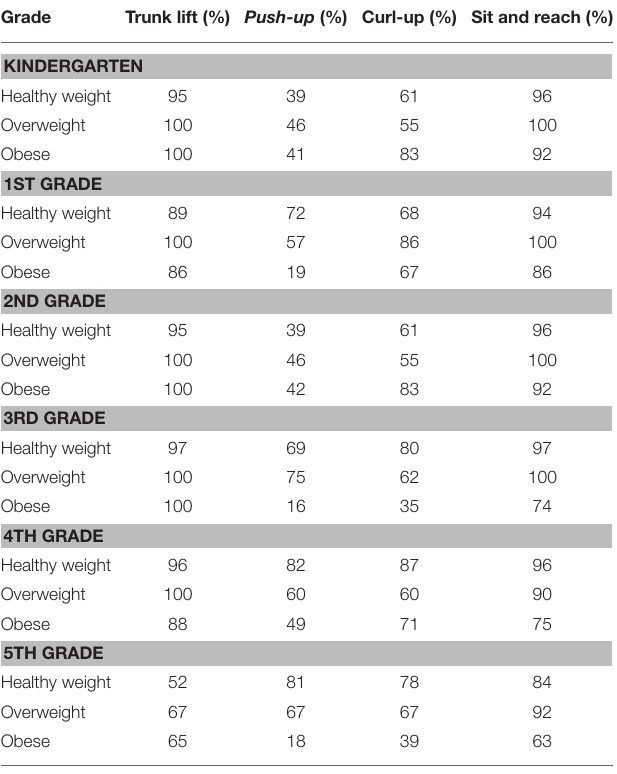
TABLE 11 | Percentage of children who achieved Healthy Fitness Zone scoring in all grades.